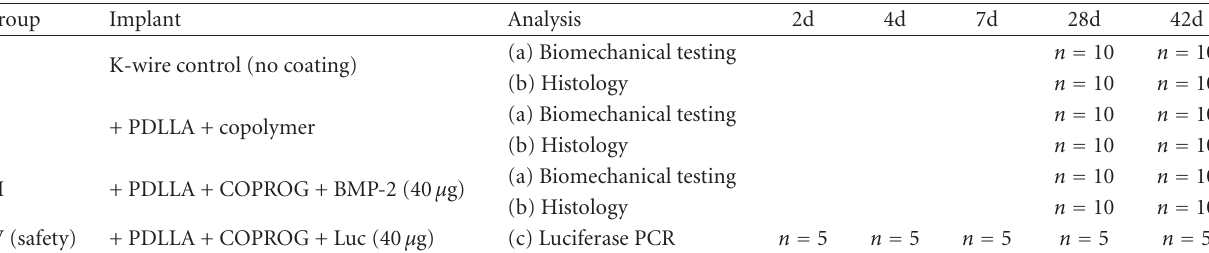
Table 1: Investigated groups and timepoints of measurements.